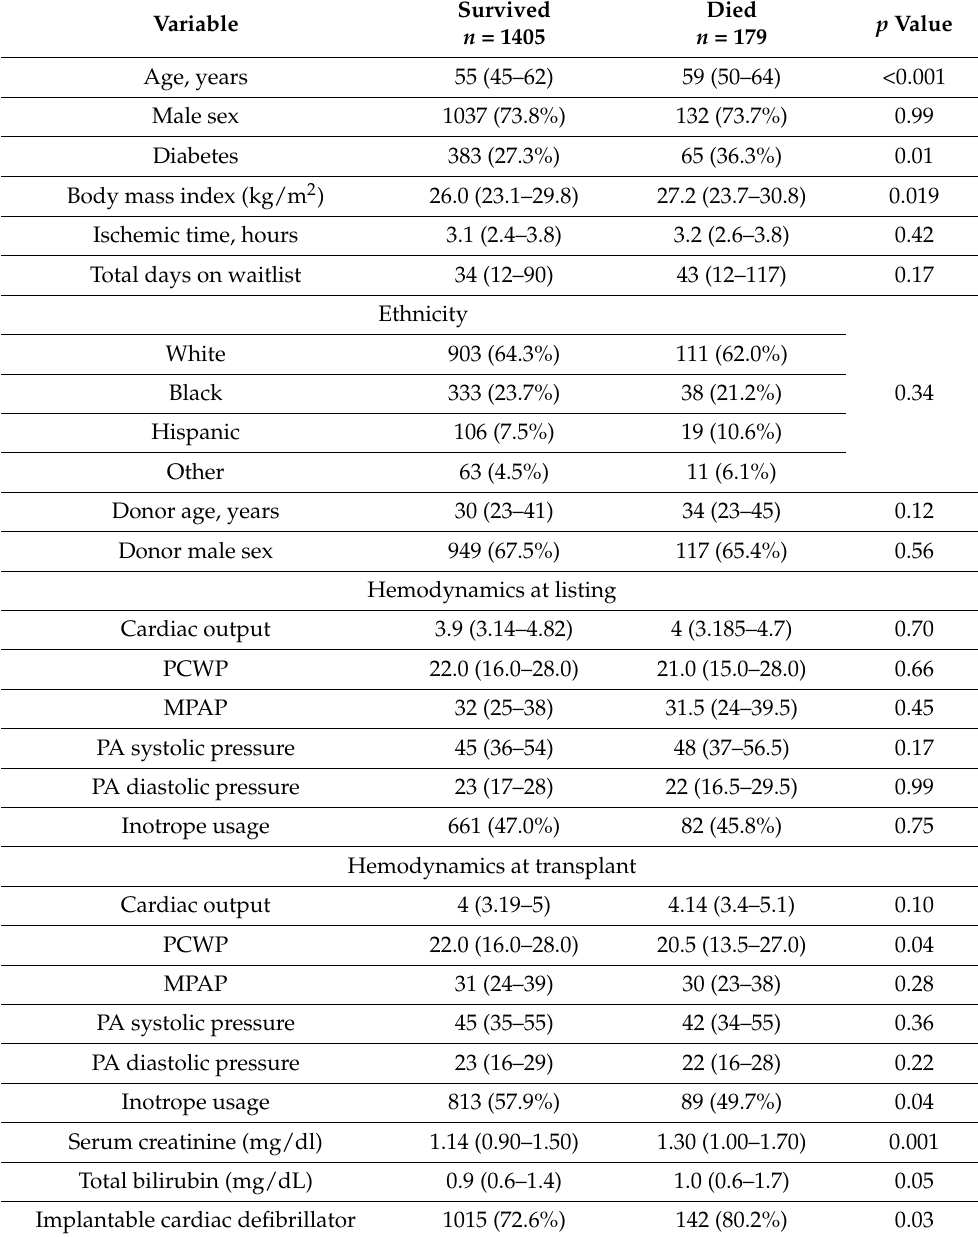
Table 1. Baseline characteristics and demographics for patients who required temporary mechanical circulatory support for bridge to transplant between survivors and non-survivors at 1-year post- transplant. Variables represent recipient characteristics unless otherwise